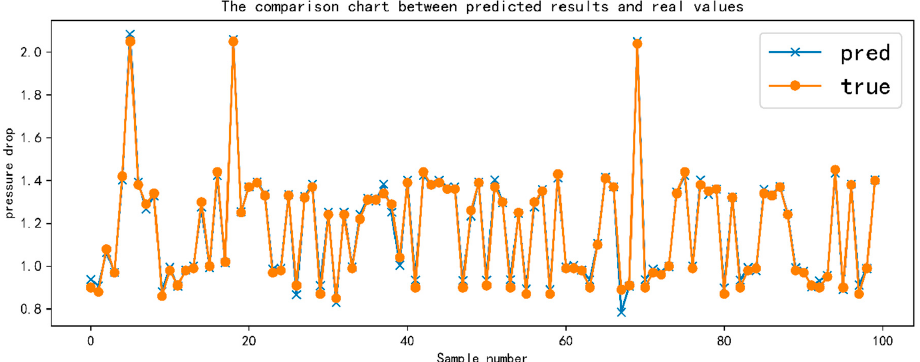
Figure 12. Prediction comparison chart of PSO-BP pressure drop model after optimization.